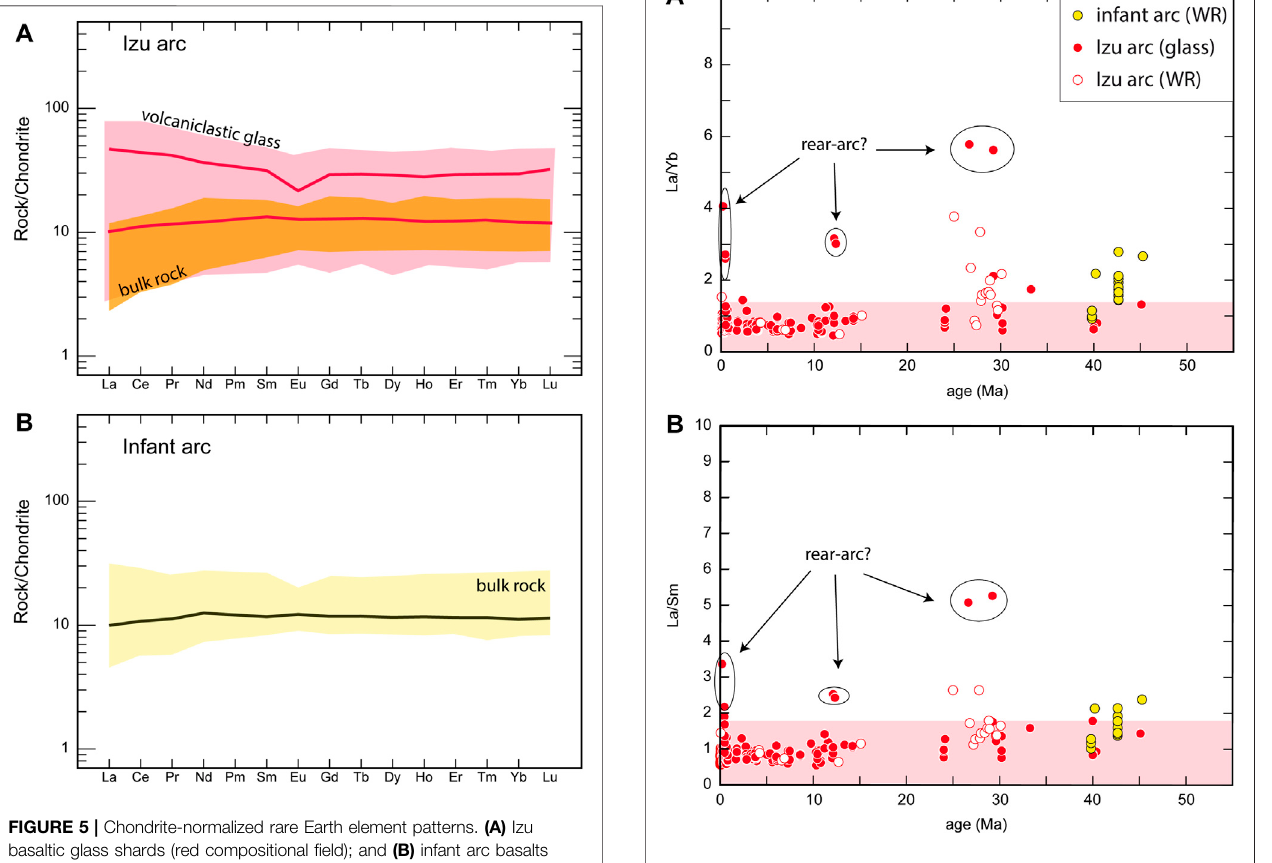
FIGURE 6 | Classi fi cation diagrams for sample provenance. (A) La/Yb and (B) La/Sm vs. time. The diagrams are used to examine the provenance of the volcaniclastics examined in this study. Some of the Izu volcaniclastics possess higher La/Sm and La/Yb ratios than most of the volcaniclastics from the volcanic arc front, as depicted by the pink compositional fi eld. High La/Yb and La/Sm are characteristics of the rear-arcmagmas, suggesting that the outliers may come from the rear-arc.